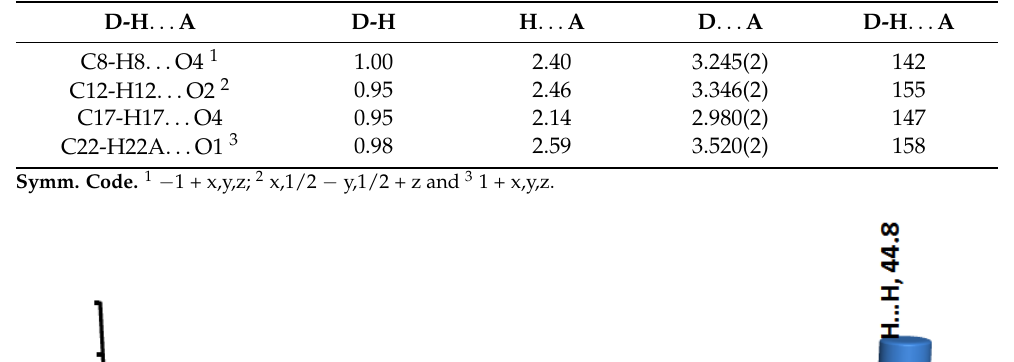
Table 3. Hydrogen bond parameters (Å and ◦ ) for 3 .